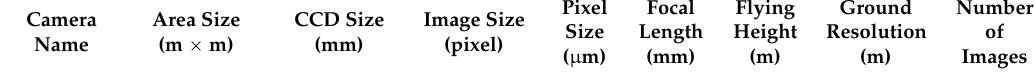
Table 3. The parameters of the photography from Hainan (unmanned aerial vehicle images). Camera